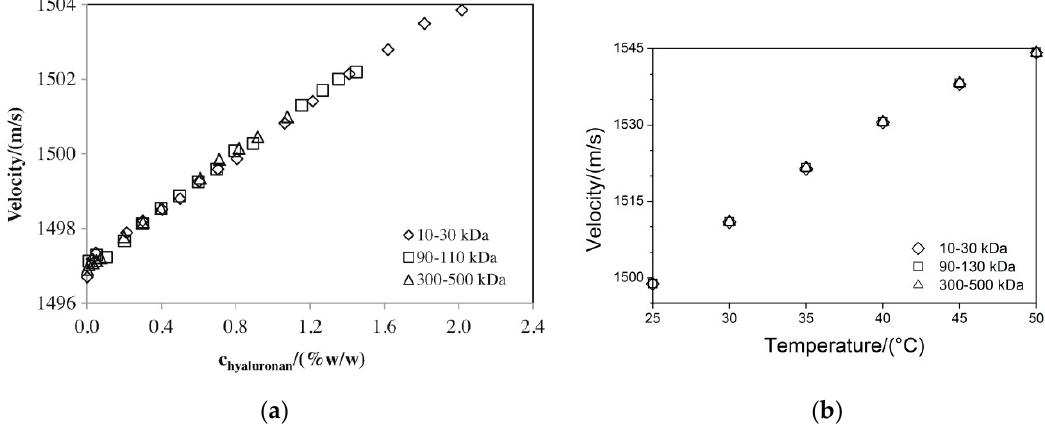
Figure 16. Dependence of ultrasound velocity for ( a ) hyaluronic acid concentration at 25 °C [80] and ( b ) temperature at 0.5% ( w / w ) concentration of hyaluronan (based on the Supplementary Materials of [80]). Adapted from [80], with permission from Elsevier, 2020.